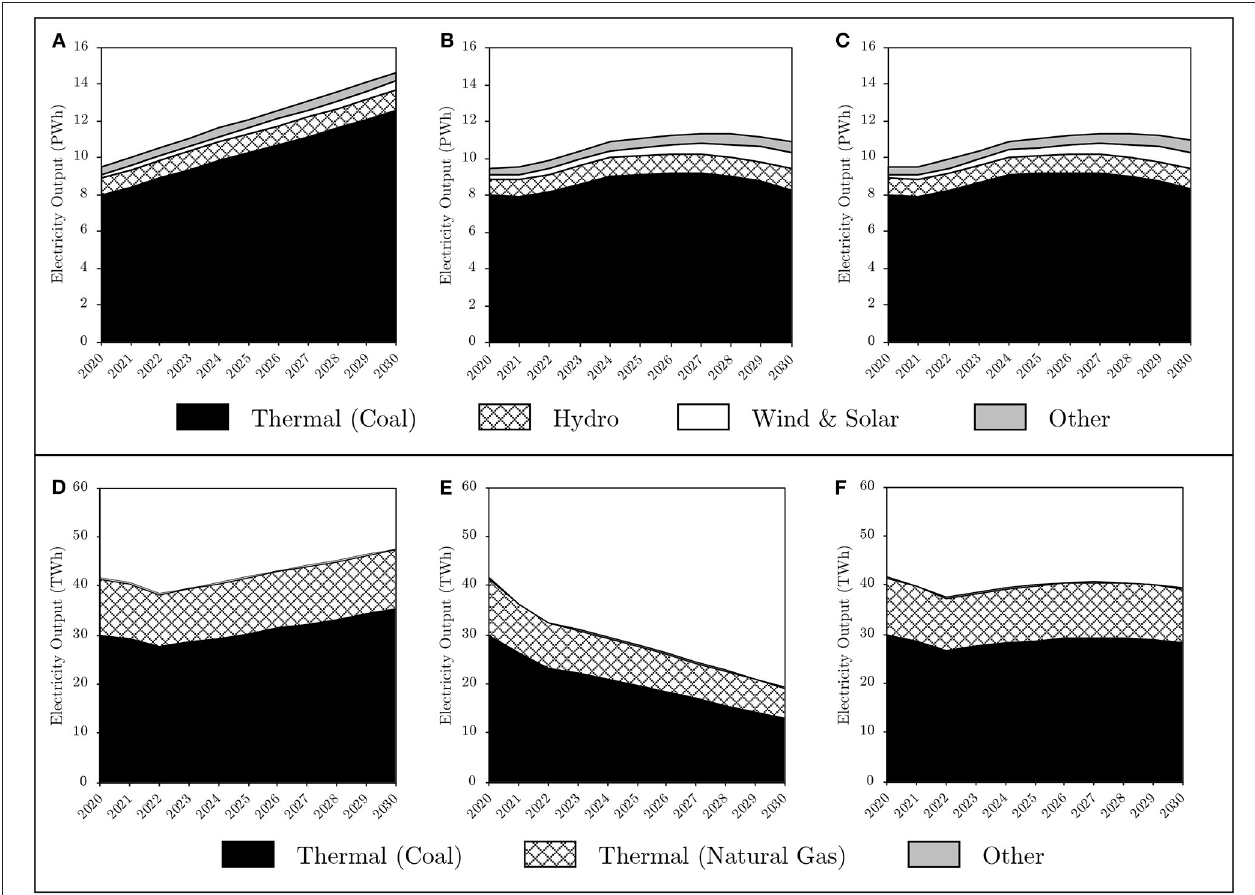
FIGURE 4 | Local electricity output mix under moderate mitigation scenarios: (A) China, BAU ; (B) China, PARIS ; (C) China, PARIS_INT ; (D) Hong Kong, BAU ; (E) Hong Kong, PARIS ; (F) Hong Kong, PARIS_INT .